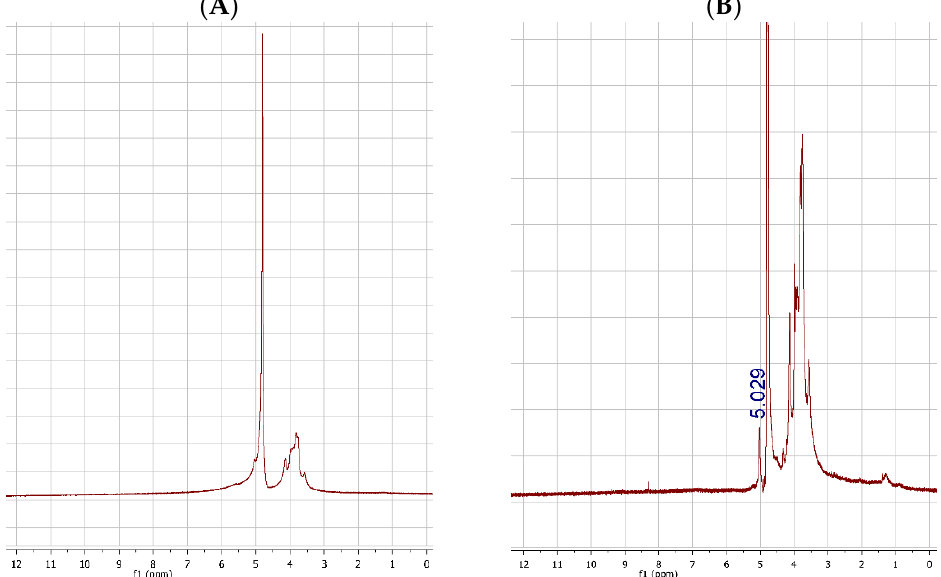
Figure 2. Panel ( A ): 1 H-NMR spectrum of BTG; Panel ( B ): 1 HNMR spectrum of PLOMW. In the panel ( B ), the signal at 5.029 ppm belongs to H 1 of α -D-galactopyranose which in the panel ( A ) collapsed into the D 2 O signal.